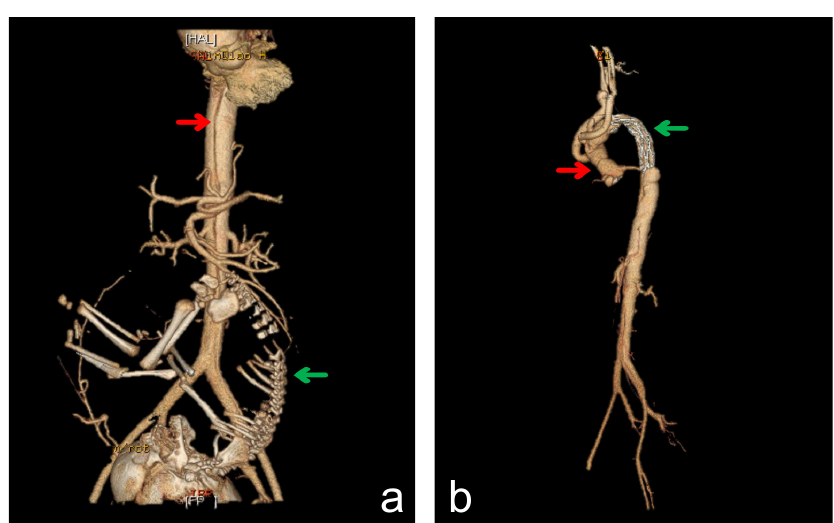
Fig. 1 - Changes in pre- and postoperative computed tomography angiography images of Case 1. (A) 3D reconstruction of preoperative CT images shows the location of thoracoabdominal aorta dissection marked by a red arrow and the fetal skeleton marked by a green arrow. (B) 3D reconstruction of postoperative CT images shows the artificial blood vessel marked by a red arrow and the covered stent graft marked by a green